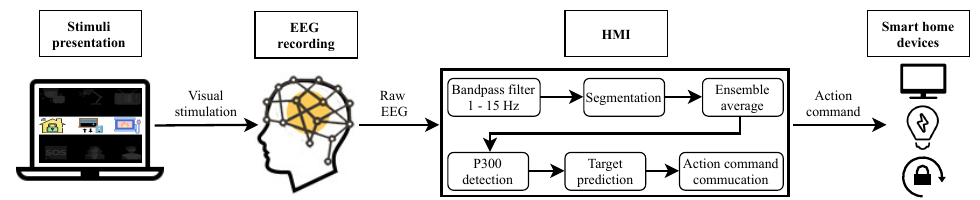
Figure 1. Electroencephalography (EEG) system based on P300 EP.